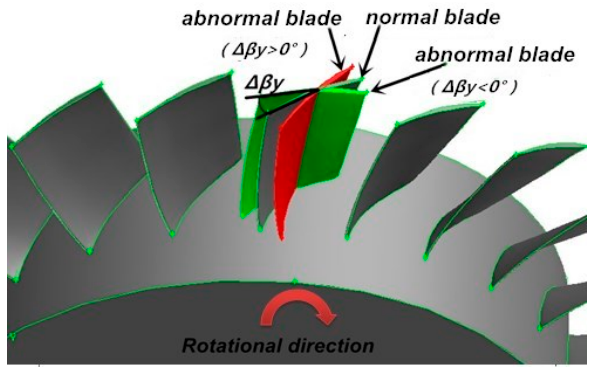
Figure 2. Diagram of the abnormal blade angle.